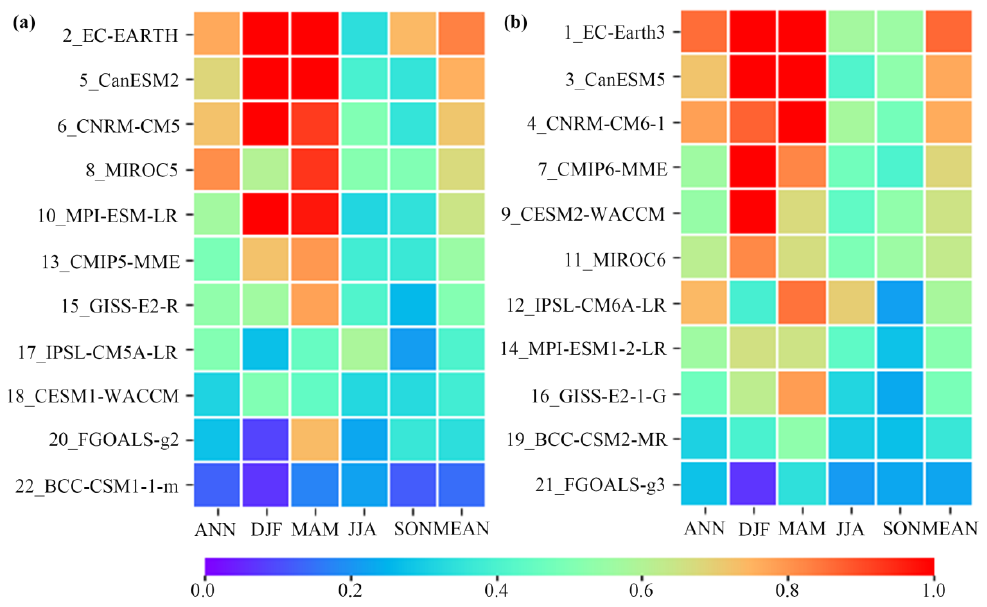
Figure 7. Normalized root-mean square error (NRMSE) in precipitation projection by CMIP5 GCMs (purple empty circles), CMIP6 GCMs (orange empty circles), CMIP5-MME (blue filled triangles) and CMIP6-MME (red filled triangles), as well as median errors (solid line).